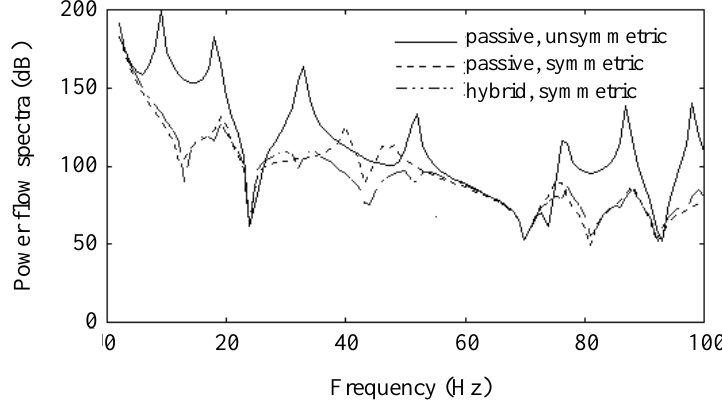
Fig. 10. Effect of symmetry of system on power flow transmission